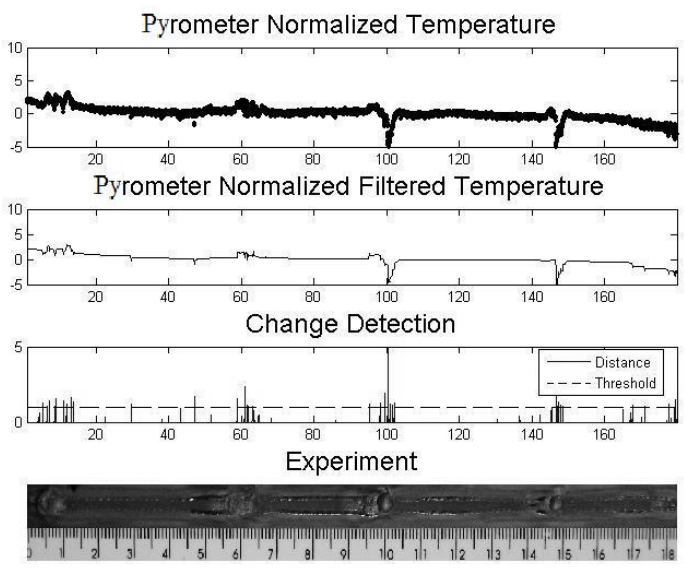
Figure 7. Plate with iron defects.